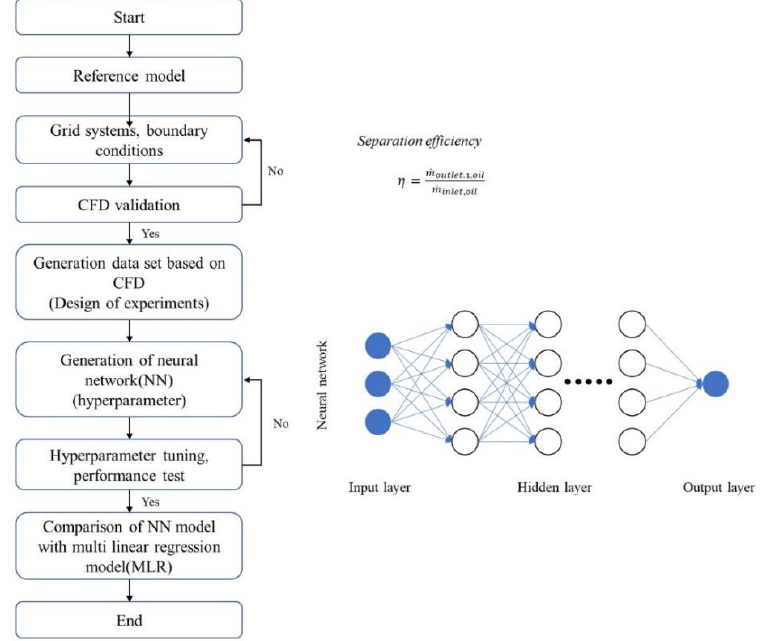
Figure 1. Research flowchart.